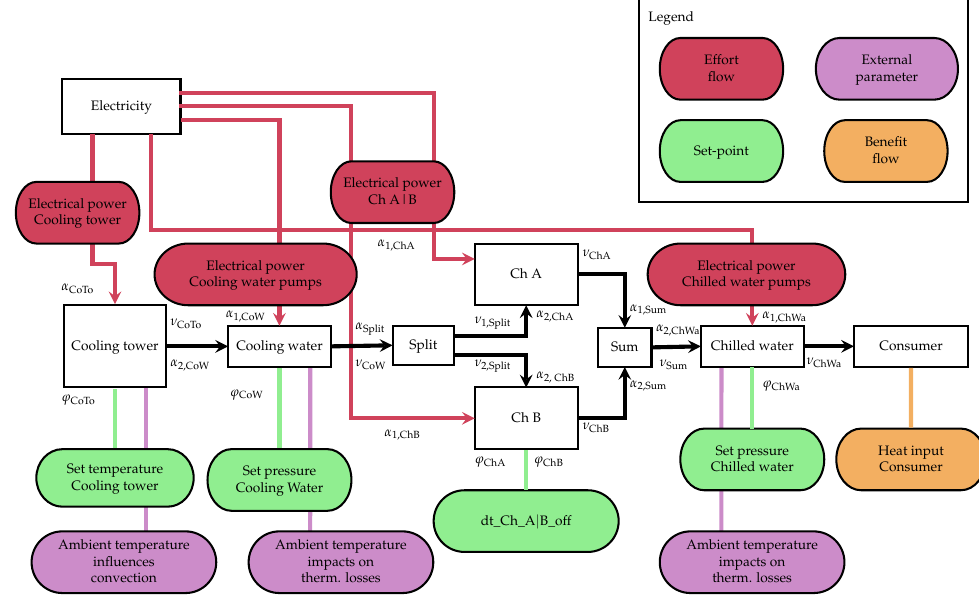
Figure 1. Schema of a typical cooling plant with assigned